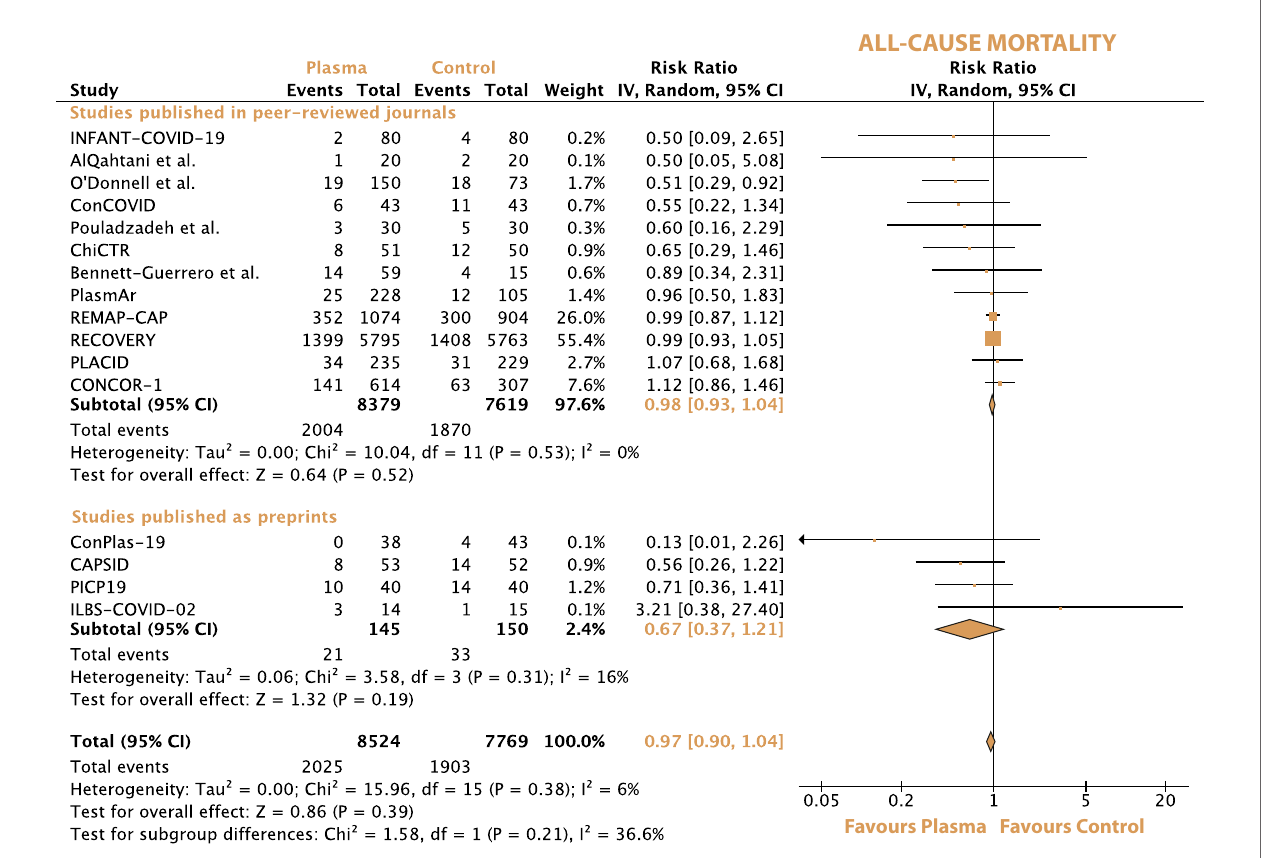
FIGURE 2 | Forrest plot depicting the risk ratio of all-cause mortality between treatment with convalescent plasma and standard of care